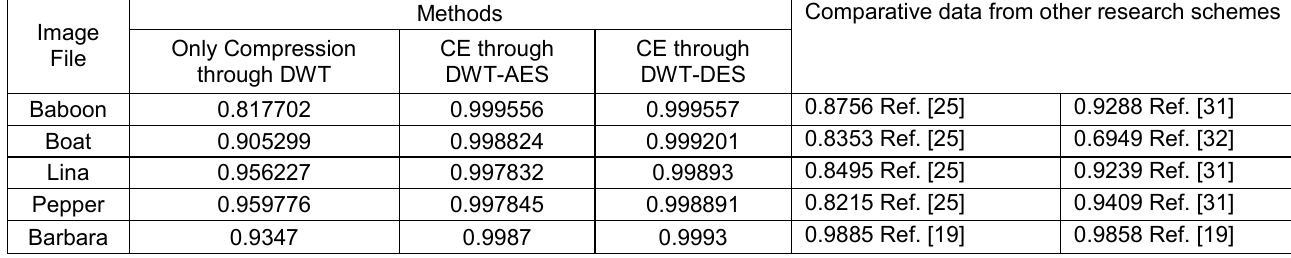
Table 5. Comparison of SSIM for different compression encryption